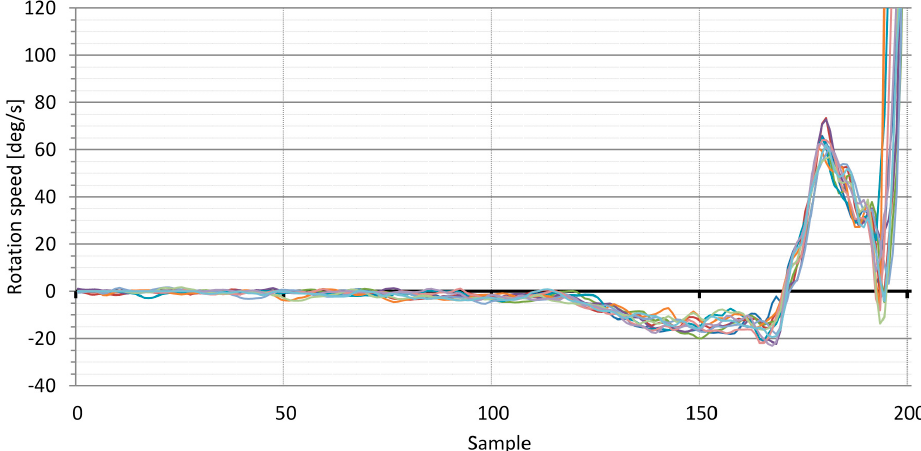
Figure 6. Series of swings performed by a professional golf player. Plots show gyroscope rotation speed around Z-axis in degrees per second. The presented last 200 samples of the swing, at sampling rate of 60 Hz, yield the analysis window of 3.33 s.